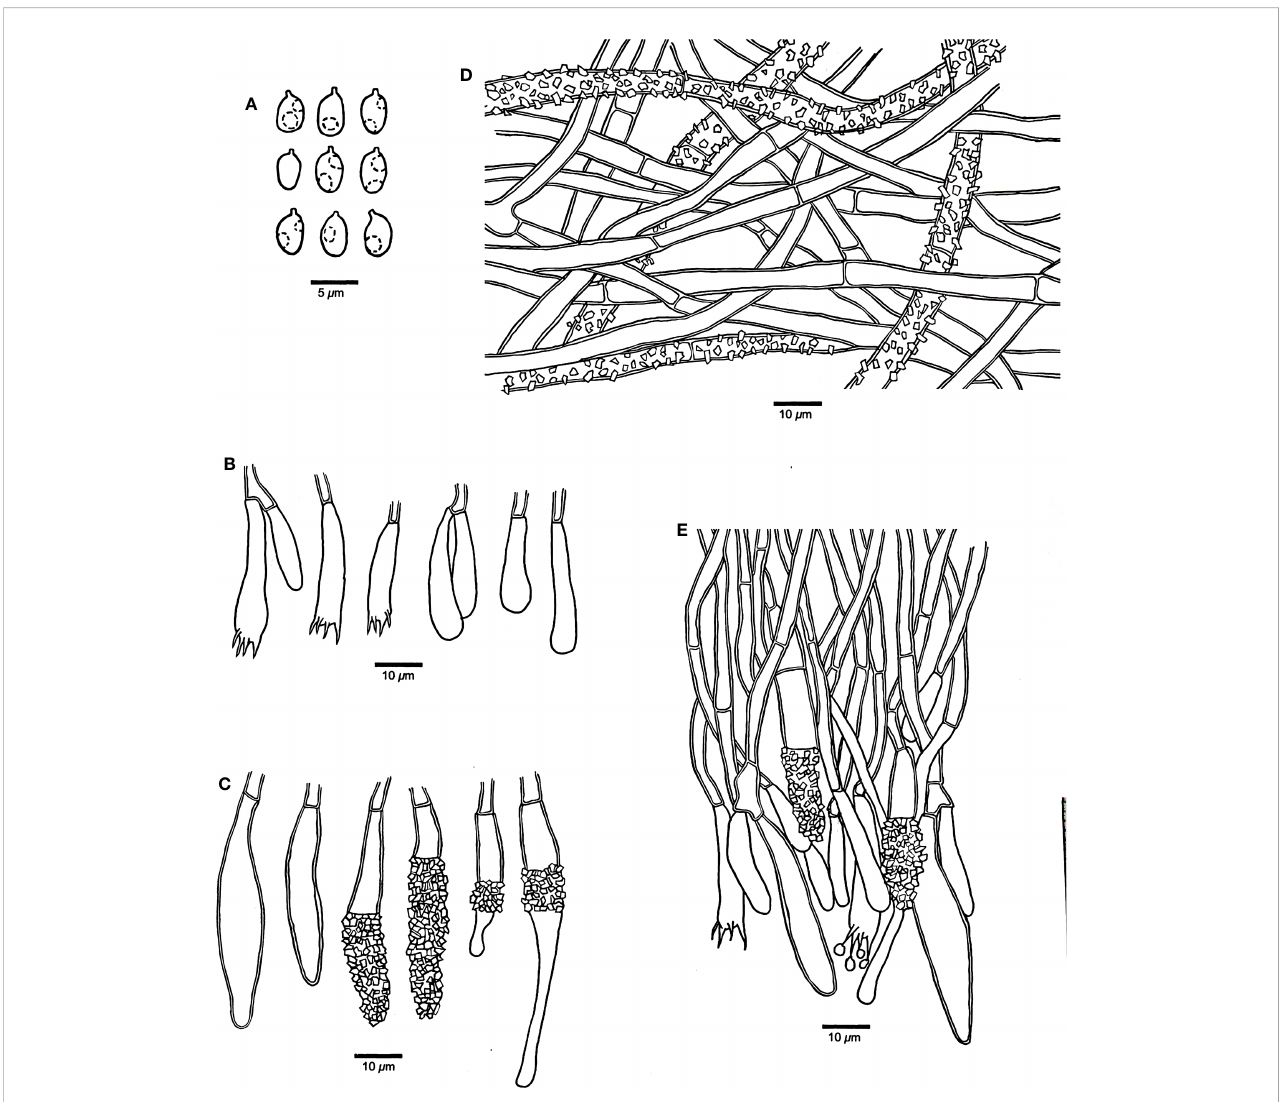
FIGURE 4 Microscopic structures of Rhizochaete variegata (drawn from the holotype, Dai 24600). (A) Basidiospores. (B) Basidia and basidioles. (C) Cystidia. (D) A vertical section of the subiculum. (E) A vertical section of the